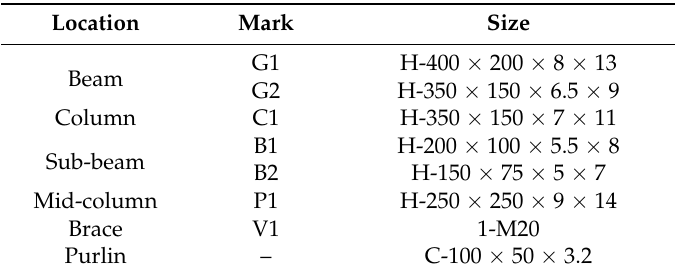
Table 1. The members’ list of the building steel